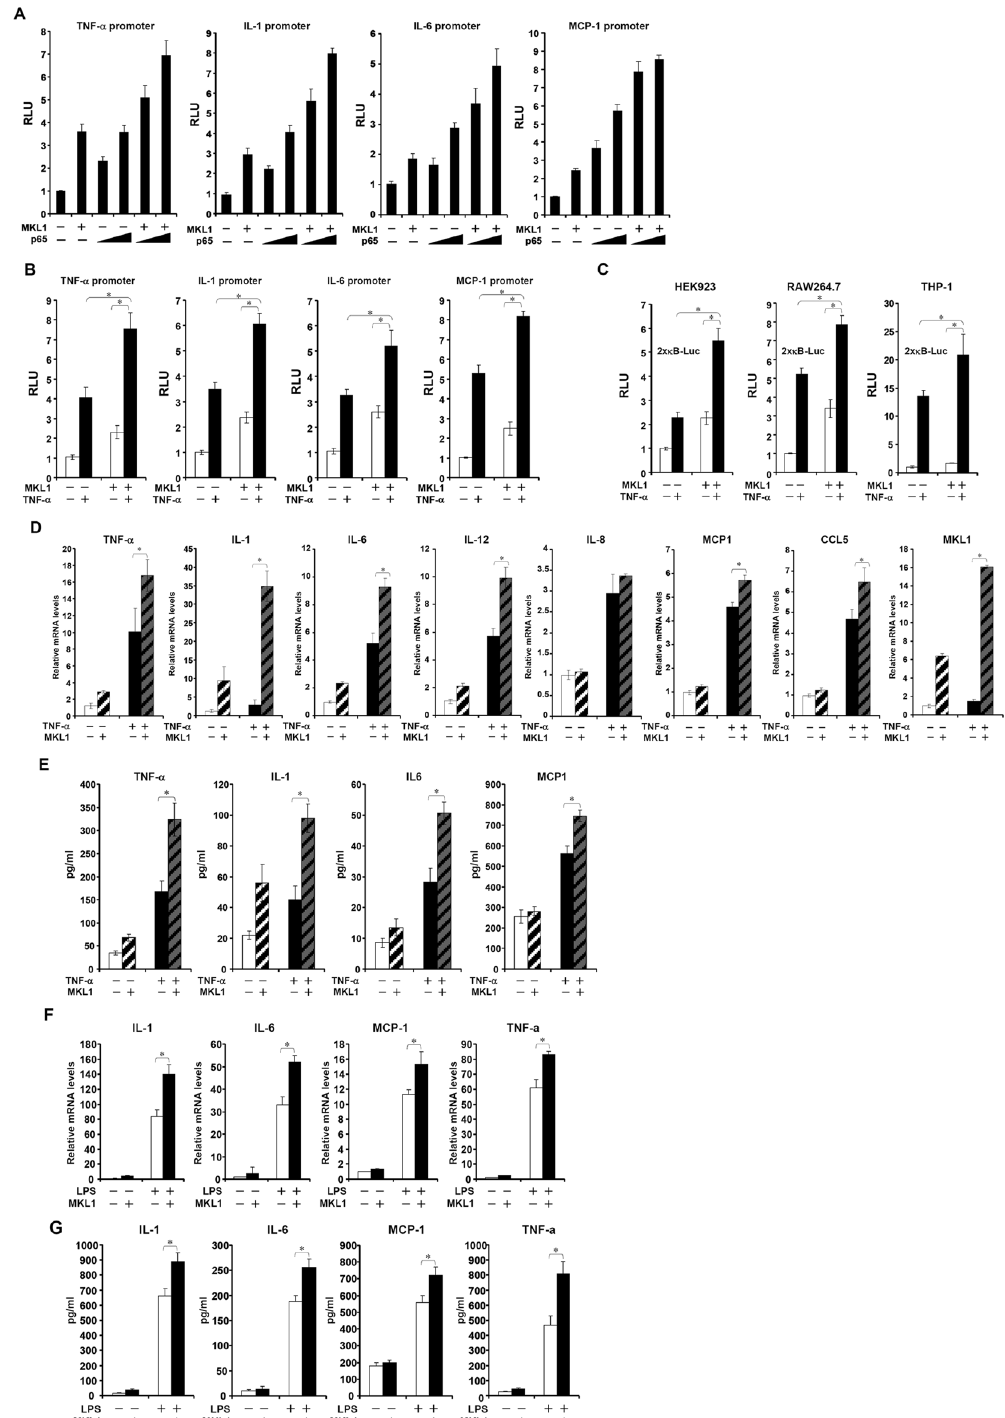
Figure 1. MKL1 enhances Rel-A/p65 dependent transcription. ( A ) FLAG-MKL1 and V5-p65 were co- transfected into HEK293 cells with indicated promoter constructs. Data are expressed as relative luciferase unit (RLU). ( B ) FLAG-MKL1 was co-transfected into HEK293 cells with indicated promoter constructs followed by treatment with TNF- α (10 ng/ml) for 6 hours. Data are expressed as RLU. ( C ) FLAG-MKL1 was co-transfected into cells with a generic κ B reporter construct followed by treatment with TNF- α (10 ng/ml) for 6 hours. Data are expressed as RLU. ( D , E ) THP-1 cells were transfected FLAG-MKL1 followed by treatment with TNF- α (10 ng/ml) for 6 hours. mRNA ( D ) and protein ( E ) levels of pro-inflammatory mediators were measured by qPCR and ELISA. ( F , G ) THP-1 cells were transfected FLAG-MKL1 followed by treatment with LPS (100 ng/ ml) for 6 hours. mRNA ( F ) and protein ( G ) levels of pro-inflammatory mediators were measured by qPCR and